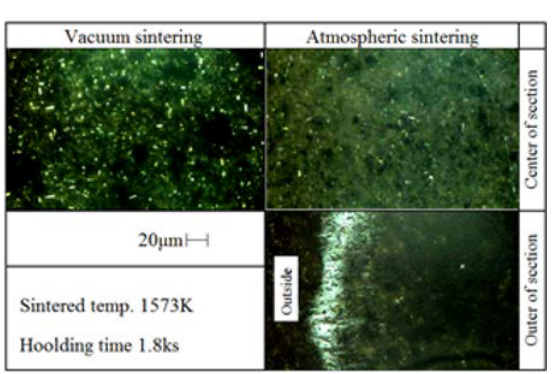
Figure 3. Examples of biomaterial parts cut from TMA vacuum- sintered bodies using a 3D- modeling machine or a lathe.